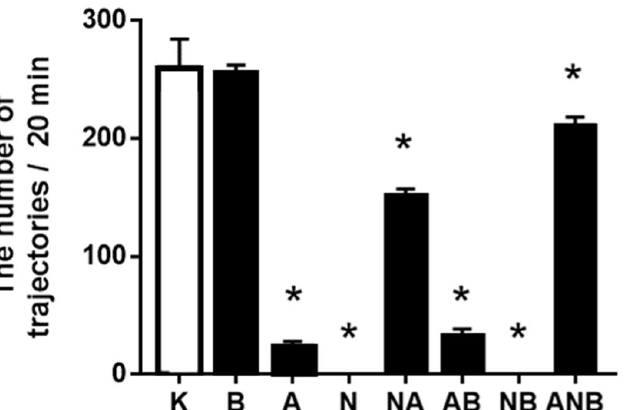
Figure 5. Total number of trajectories in the open field/20 min. The total number of ketamine-induced trajectories in the open field test, mean values, and 95 percent confidence intervals are presented. In the ketamine rats (30 mg/kg ip), medication (mg/kg ip) was: L-NAME (5) (N), L-arginine (100) (A), BPC 157 (0.01) (B), alone and/or together (L-NAME+L-arginine (NA), L-arginine+BPC 157 (AB), L-NAME+BPC 157 (NB), L-arginine+L-NAME+BPC 157 (ANB)), and saline 5 mL/kg ip (control ketamine) (K). The application was immediately before ketamine (L-NAME, L-arginine, and combination) or the application was immediately after ketamine (BPC 157 and combinations). Dunnett’s multiple comparison test was used to compare control group (K) with treated groups.* p < 0.05 versus ketamine.